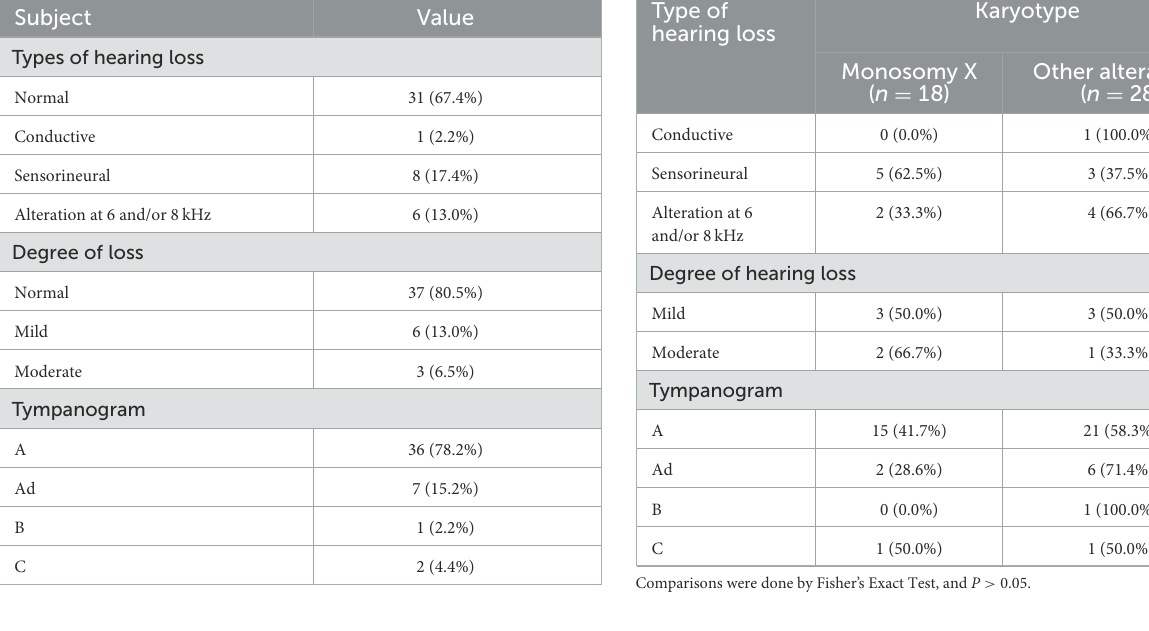
TABLE 3 Threshold of hearing at different frequencies for different